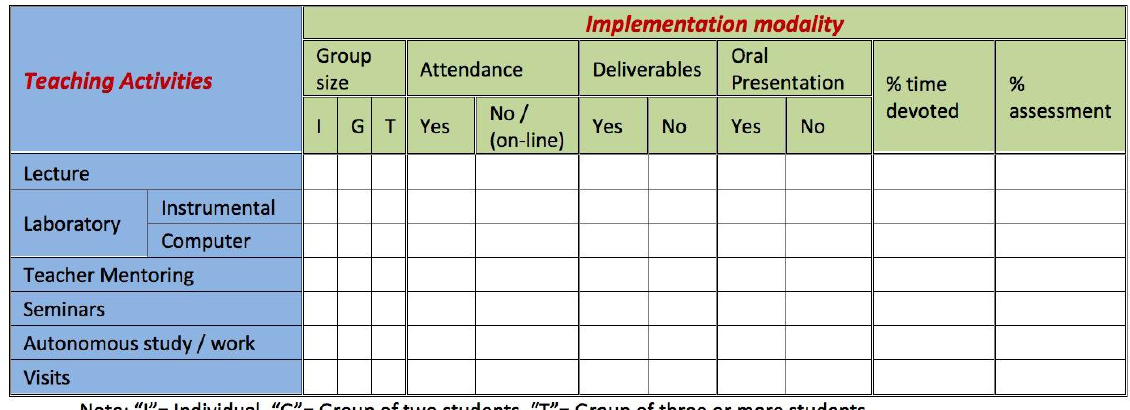
Fig. 3. Teaching methodologies card: Implementation modality vs. Teaching